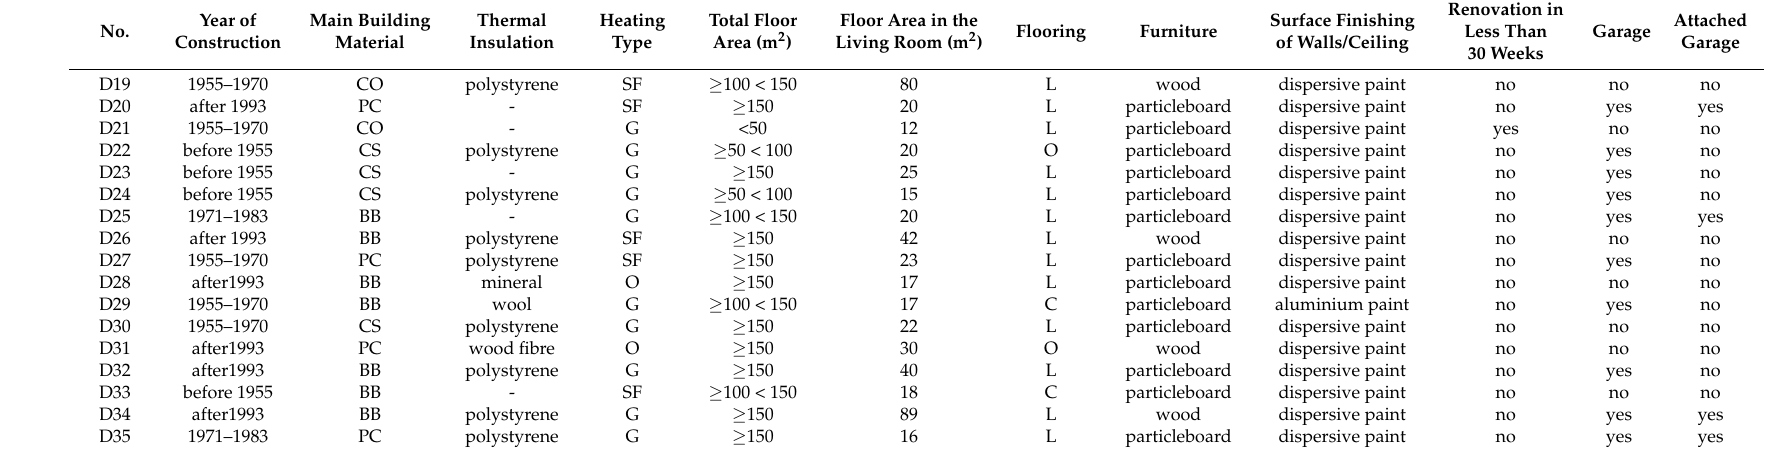
Table A3. Basic information about the family houses—Part 1.